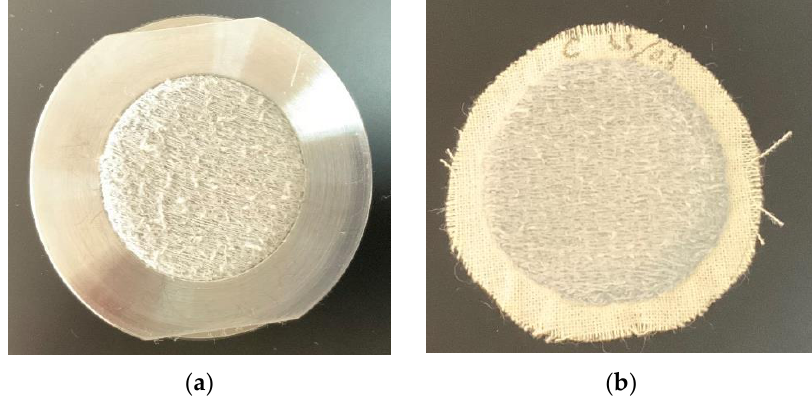
Figure 9. Sample C after 10,000 frictions ( a ), sample C after 25,000 frictions ( b ).